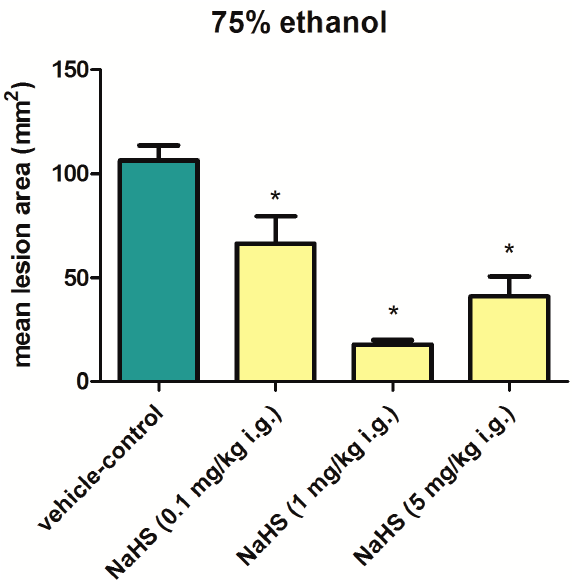
Figure 3. Mean lesions area of rats’ gastric mucosa exposed to 75% ethanol. Thirty minutes before intragastric (i.g.) application of 75% ethanol, animals were pretreated with saline or NaHS (0.1–5 mg/kg). Results are mean ±S.E.M of 6 rats per each group. Asterisk indicates significant ( p < 0.05) difference in mean lesions area as compared with vehicle-control